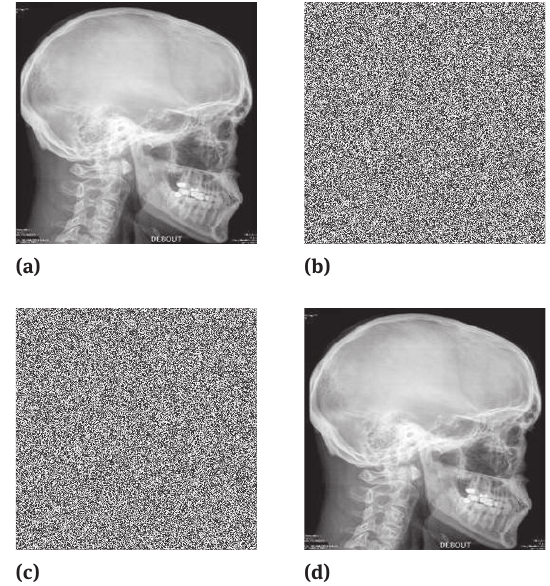
Fig. 5: Skull: (a) Original image, (b) Ciphered image, (c) Stego- image, (d) Decrypted image.